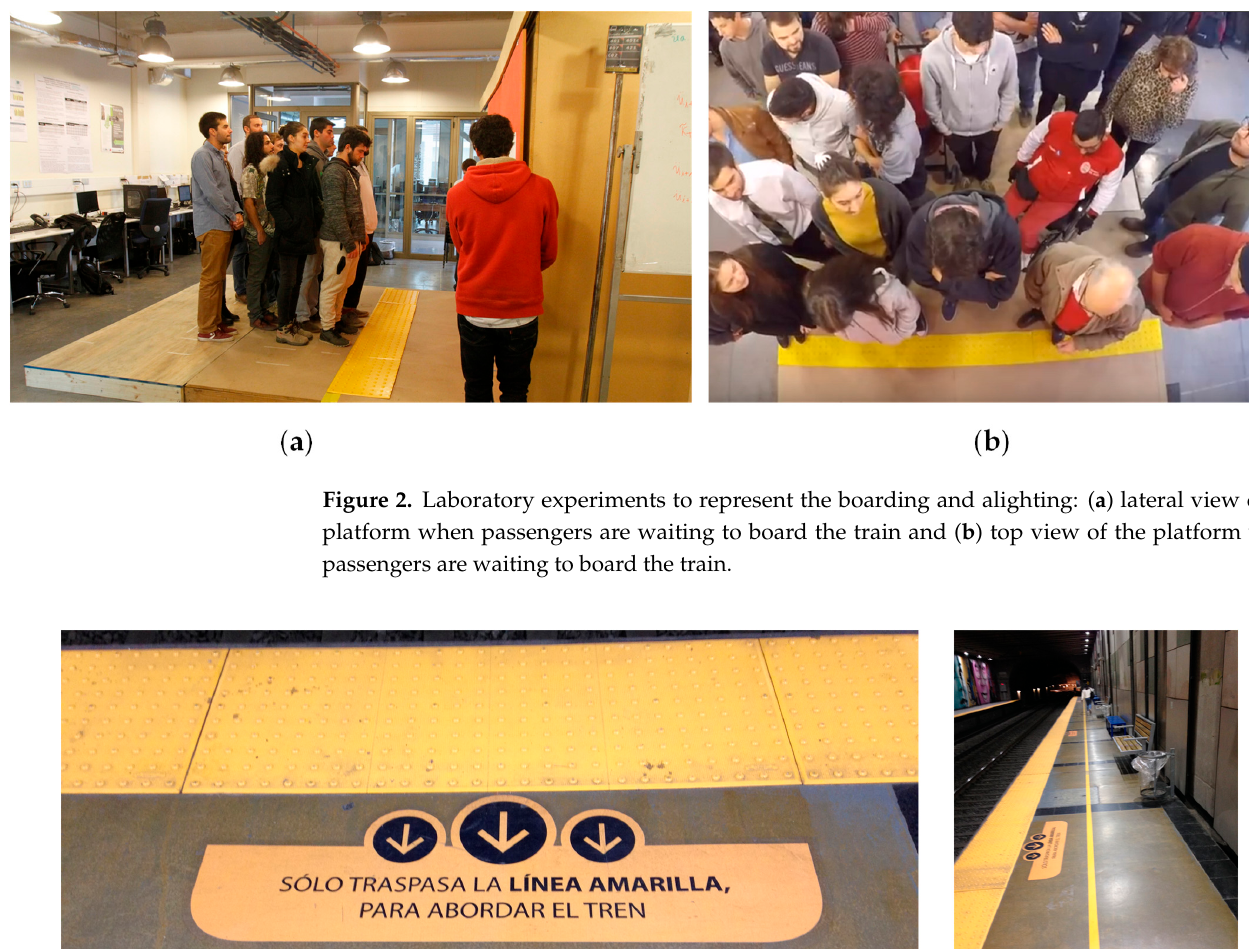
Figure 3. Yellow safety line observed in metro stations in the Valparaiso Metro, Chile: ( a ) 60 cm width (carbon and fiberglass reinforced with yellow pods) used with the marking “only cross the yellow safety line when boarding the train” and ( b ) the yellow safety line is used with another yellow line in the middle of the platform to encourage movement on the right-hand side and prevent passengers walking next to the platform edge.